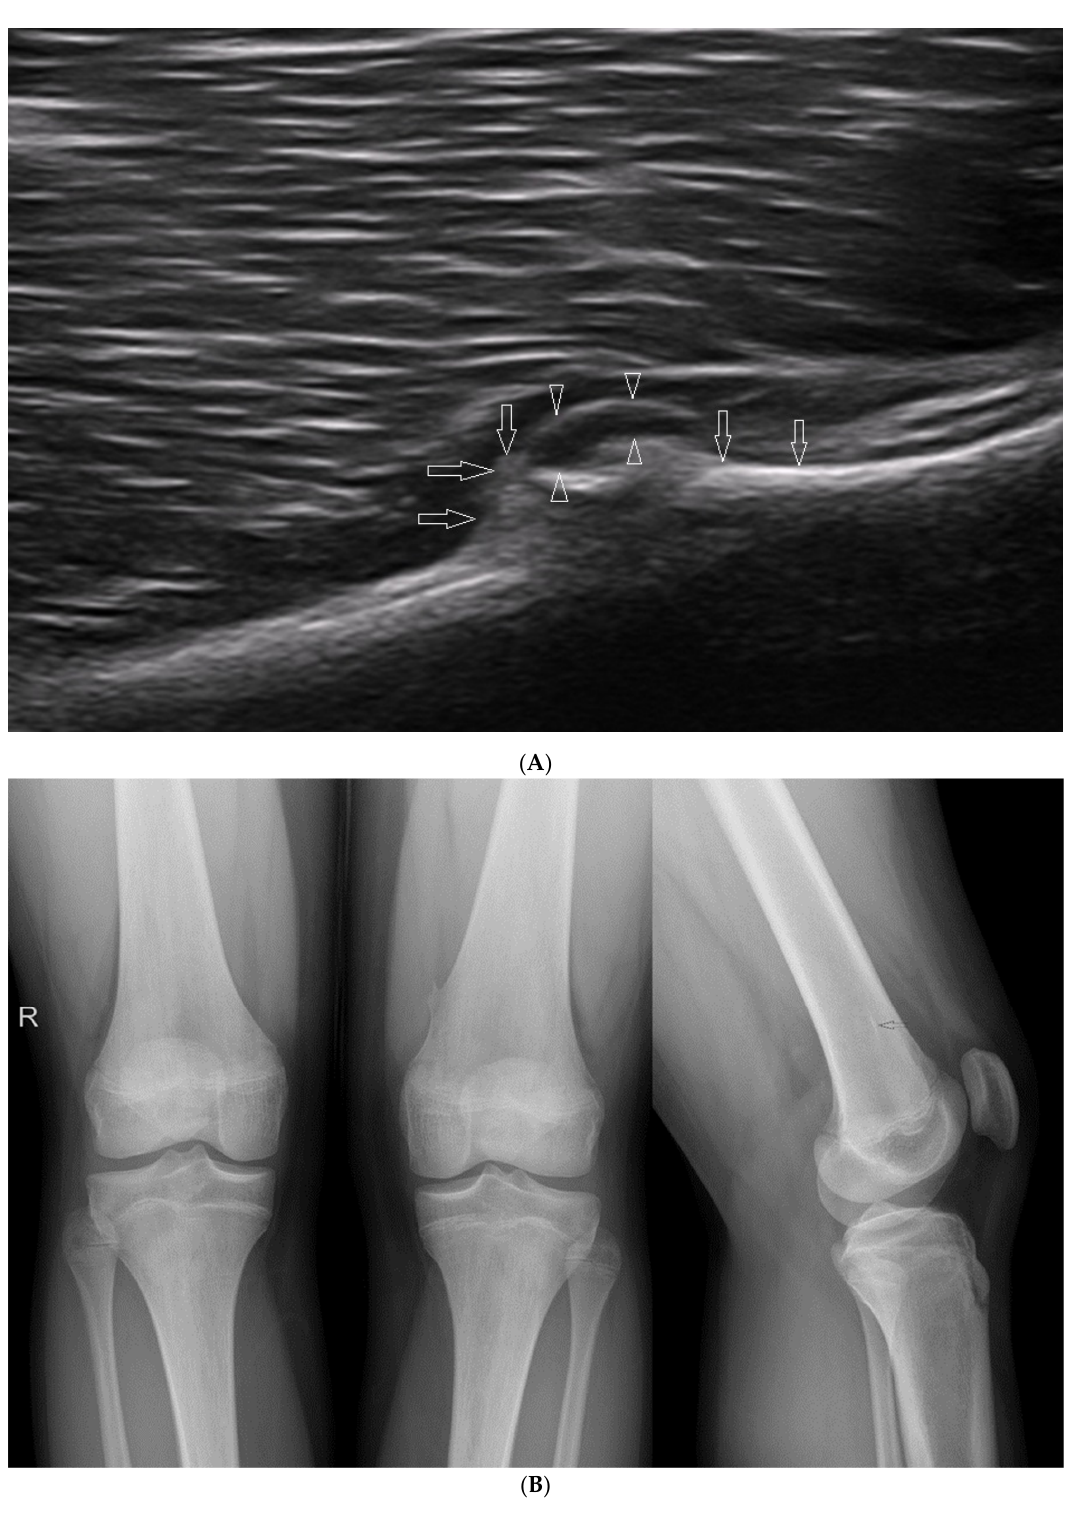
Figure 15. ( A ) An example of an osteochondroma exostosis of the left femur of a 16-year-old boy. Long axis view. Arrows—bony part of the exostosis; arrowheads—partly built of hyaline cartilage (anechoic). Linear probe 3–19 MHz. ( B ) Comparative anteroposterior X-ray image of the knee joints from the same patient and lateral image of the left knee joint, with visible osteochondroma of the left femur. Small empty arrow—longitudinal shadow corresponding to the exostosis on the lateral